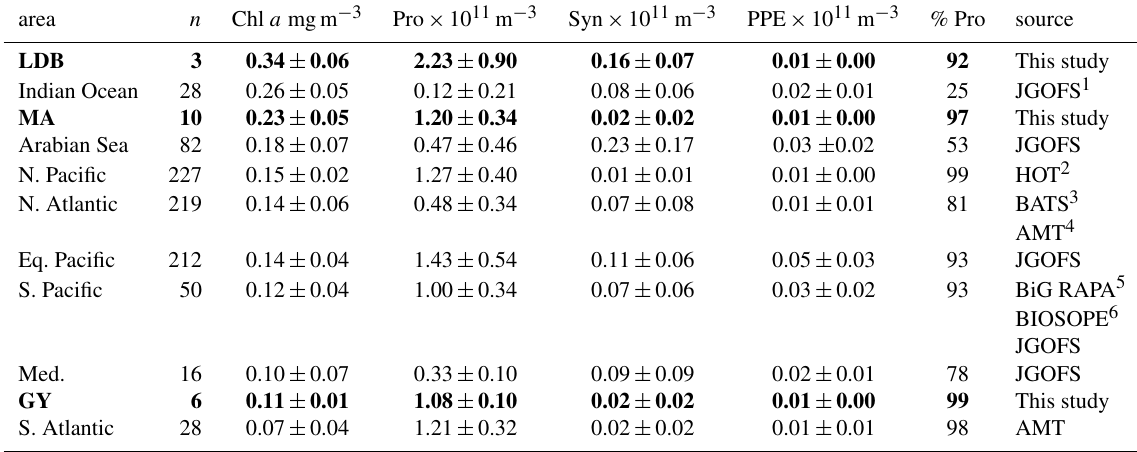
Table 4. Mean depth-normalized abundances for Prochlorococcus (Pro), Synechococcus (Syn), picophytoeukaryotes (PPE), and depth- integrated concentration of Chl a . %pro calculated as pro/(pro+syn+ppe) . Values for different biogeochemical conditions sampled during the OUTPACE transect in bold. Depth-normalized values provided to account for differences in the depth of integration between sampling sites (data not shown). OUTPACE Chl a values correspond to discrete fluorometric data collected at each station of the transect, with the exception of SD 1–3. Chl a values from other datasets correspond to discrete fluorometric or HPLC data.